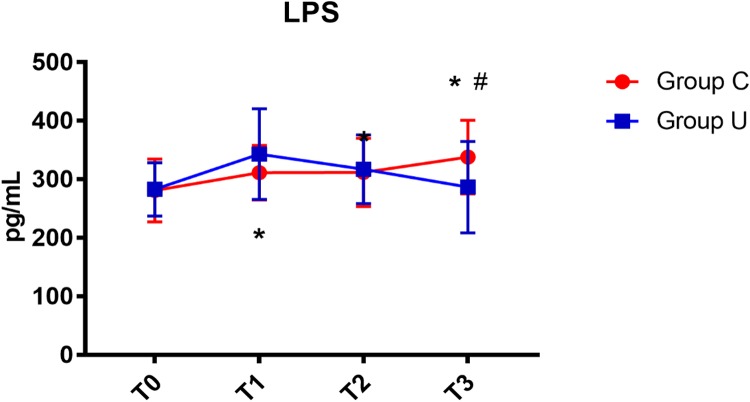
LPS concentrations over time. LPS, lipopolysaccharide; Group C, the control group; Group U, the ulinastatin group. ∗P < 0.05 from T0 in group C and group U (statistically significant), #P < 0.05 from group U (statistically significant). T0 = before skin incision, T1 = the end of operation, and T2 and T3 = 24 and 72 h postoperative.